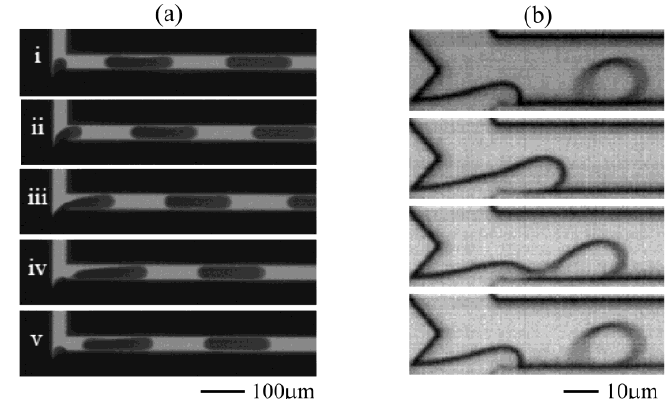
Figure 2. head-on devices ( a ) T-shaped junction, time sequence of droplet formation in the regime of squeezing. Reprinted from [47] with permission from University of Twente;